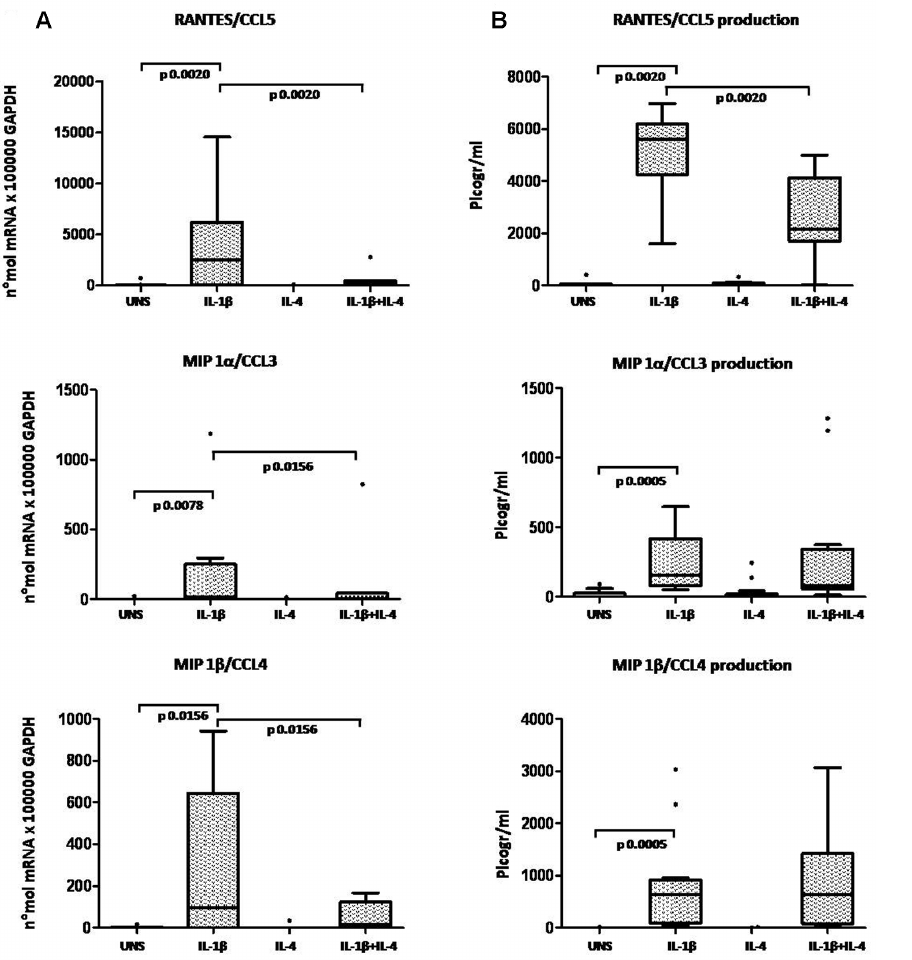
Figure 6. Evaluation of IL-4 anti-inflammatory activity on CC chemokine expression in high-density OA chondrocytes. A : mRNA expression; B : protein production. Chemokines were detected in chondrocytes (cells and culture supernatants) after 24 hours’ incubation in unstimulated conditions (UNS) and in the presence of IL-1 b (2 ng/ml), IL-4 (10 ng/ml), or a combination of the two cytokines. Boxes indicate the 25% and 75% percentiles, whiskers indicate the minimum to maximum values, bars indicate the median; solid circles indicate outliers. After Bonferroni’s correction, p values below 0.0165 were considered significant.